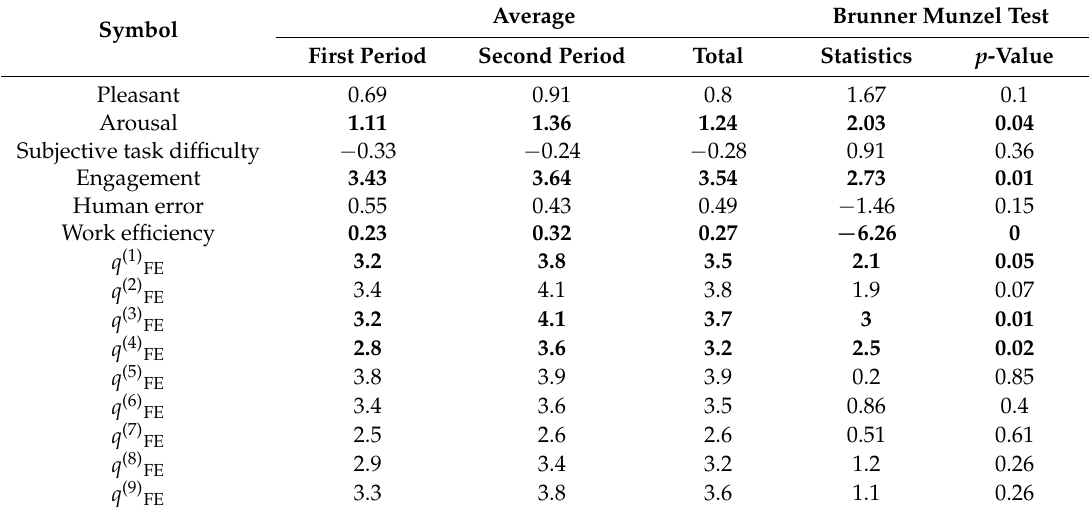
Table A1. Effect of the target on pleasant emotion, Arousal, subjective task difficulty, engagement, human error, work efficiency, and flow experience.